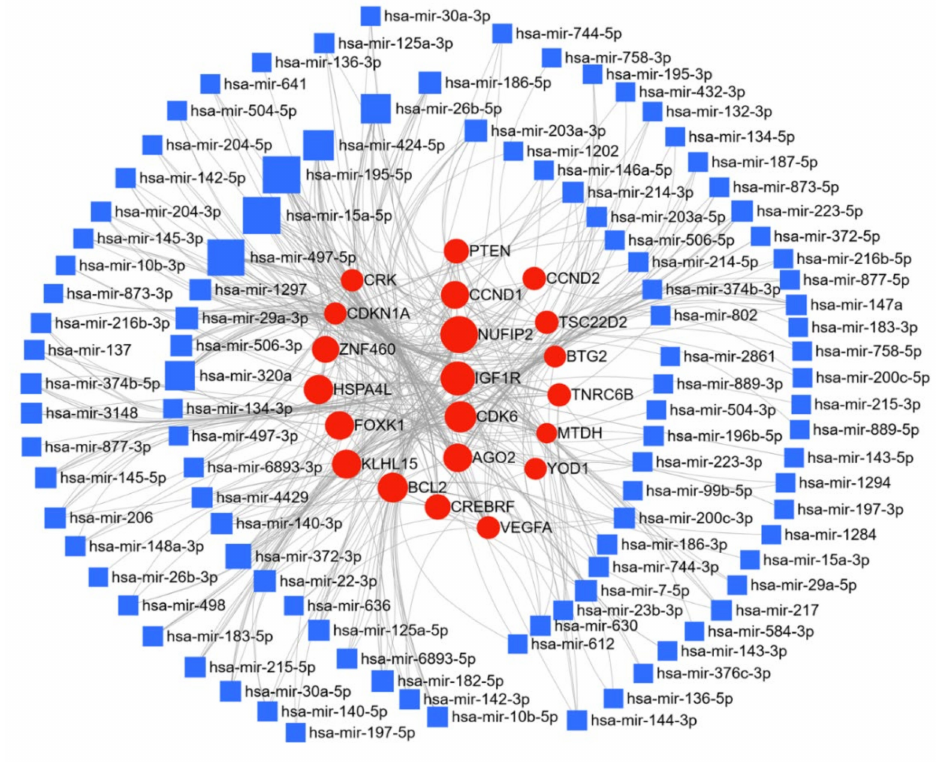
Figure 9. Network of downregulated miR in cervical cancer: miR deregulated in cervical cancer were searched in the PubMed database using IRIDESCENT. The network of downregulated miR generated using miRNET (degree filter 10) is shown. The blue squares represent miR, and the red dots represent target genes of these miRs. Table 6. Altered Pathways by Deregulated miR in Cervical